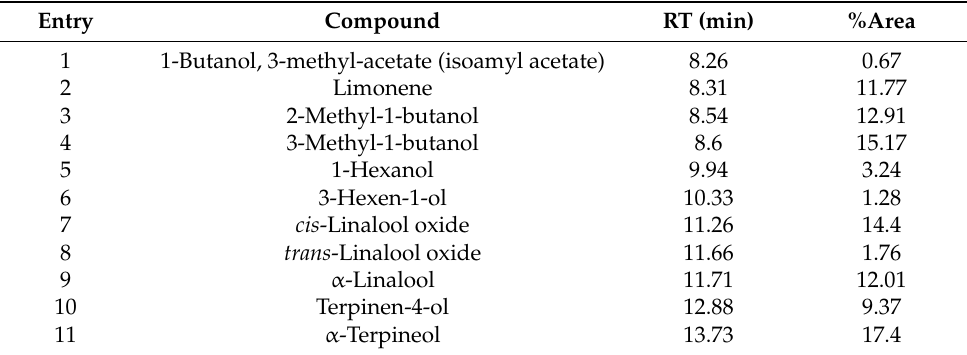
Table 2. Volatile organic compounds in grapefruit IntegroPectin.